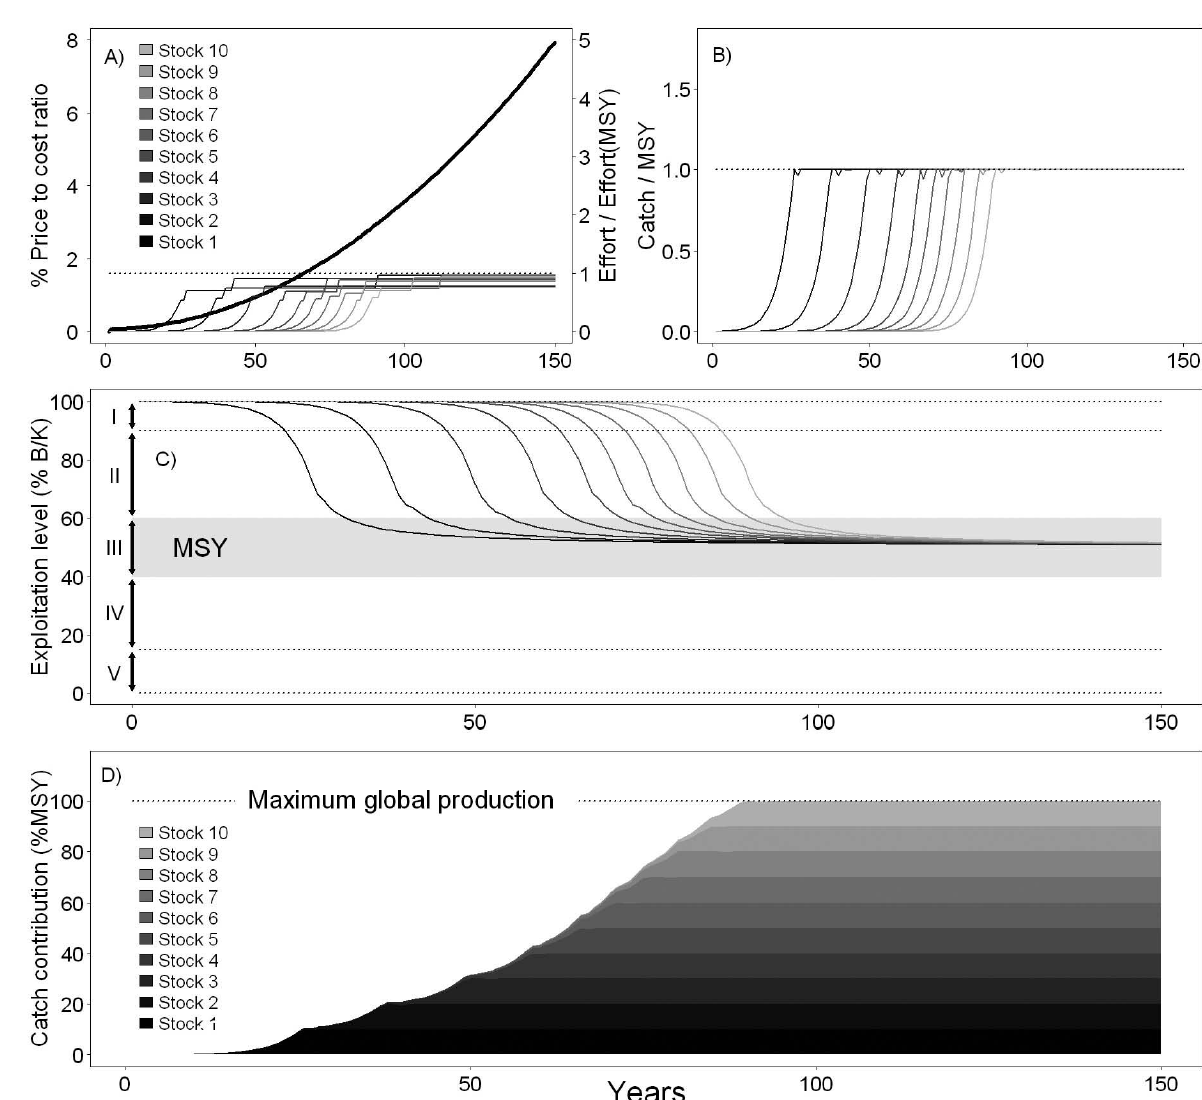
Fig . 2. – Dynamics of the global fisheries over a 150-year simulation, driven solely by an increase in the demand for marine commodities, and managed according to MSY criteria. A) Price of the marine commodity as a function of its production cost (thick line), representing the change in demand (averaged for the 10 fisheries). The fishing effort applied by regional fisheries in their fish stocks in relation to the effort that would produce maximum sustainable catches is shown in thinner grey shades. Dotted line represents the effort that would produce maximum sustainable catches. B) Regional fisheries catch in relation to their MSY values over 150 years. MSY is indicated by a dotted line. C) Available biomass in the regional stocks, in relation to their pristine levels, and indication of the exploitation phases for each stock (I, Pre-development; II, Growth; III, Full exploitation; IV, Overexploitation; V, Collapse; VI, Recovery). Grey region indicates MSY obtained when the available biomass is nearly 50% of the carrying capacity. Note that the MSY regulation under conditions of biological equilibrium prevents stocks from reaching overexploitation. D) Global fisheries production in 150 years, in relation to their potential maximum, which is achieved when the 10 fisheries are fully exploited. The maximum global production is thus related to the maximum potential productivity of marine ecosystems in stable